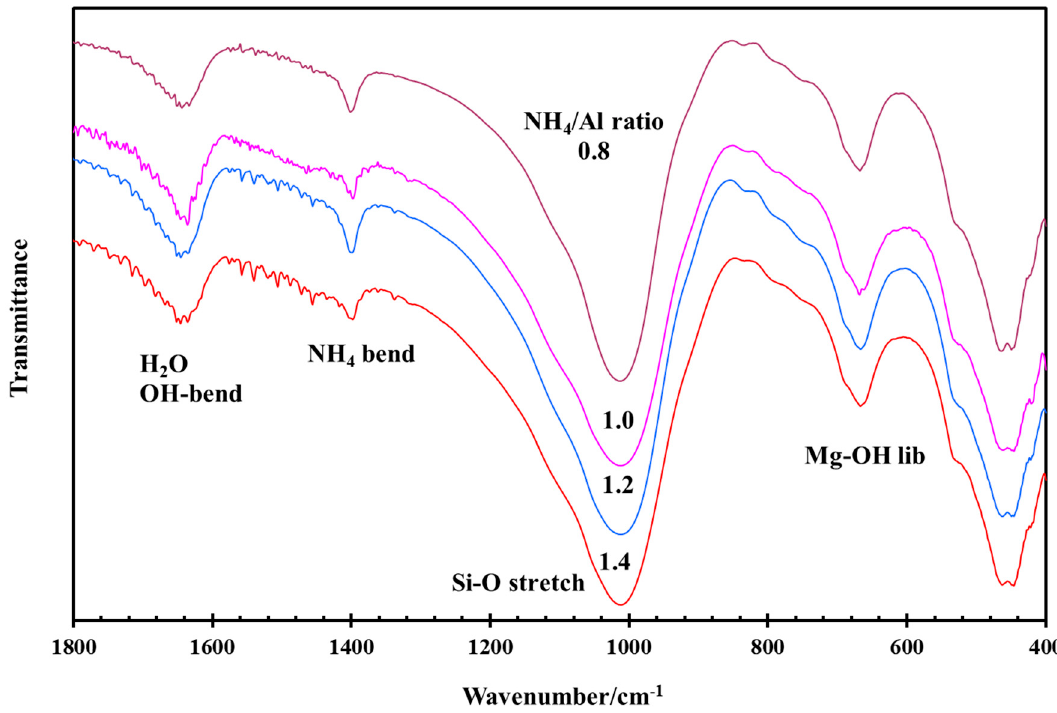
Figure 7. Mid-IR spectra in the region between 1800 and 400 cm − 1 of NH 4 -saponites synthesized with different NH 4 /Al ratios at 280 °C (modified after [57]).